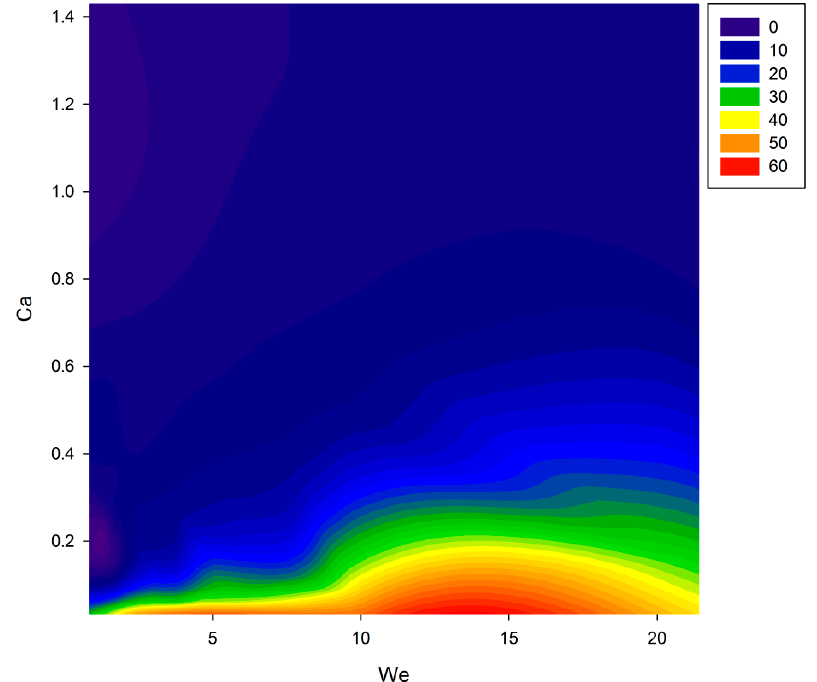
Figure 10. Z as a function of the We–Ca space (obtained from the 25 runs).